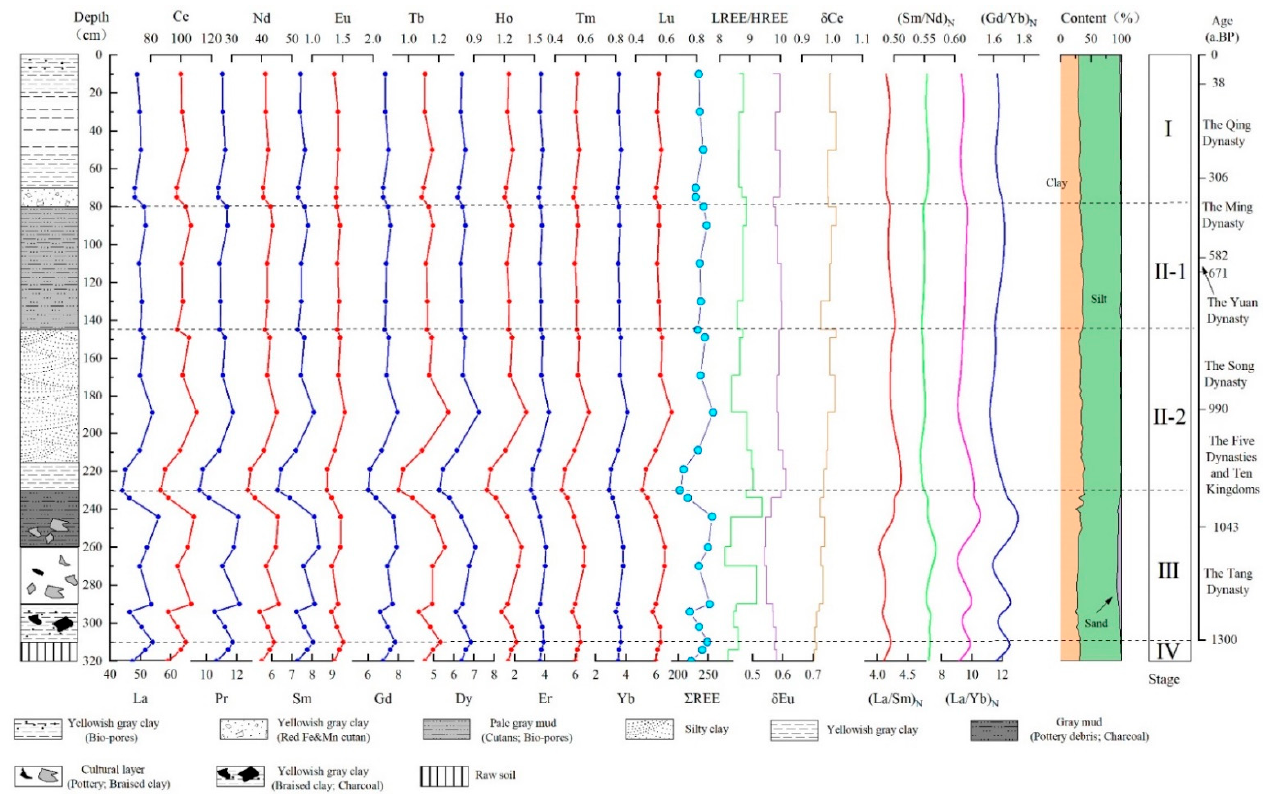
Figure 3. Vertical distribution change of the REEs (mg·kg − 1 ) and Parameter characteristics in the SZP section. The chronological framework of Chinese historical periods was based on the time of the demise of the dynasty (1332 a.BP for the founding of the Tang Dynasty). The profile was divided into four parts, stage I, II, III, and IV based on the variation of the Σ REEs and the lithology. Stage II was analyzed in two parts(II − 1, II − 2 ). Table 3. The REEs concentrations from sediments in the SZP section (mg·kg − 1 ).